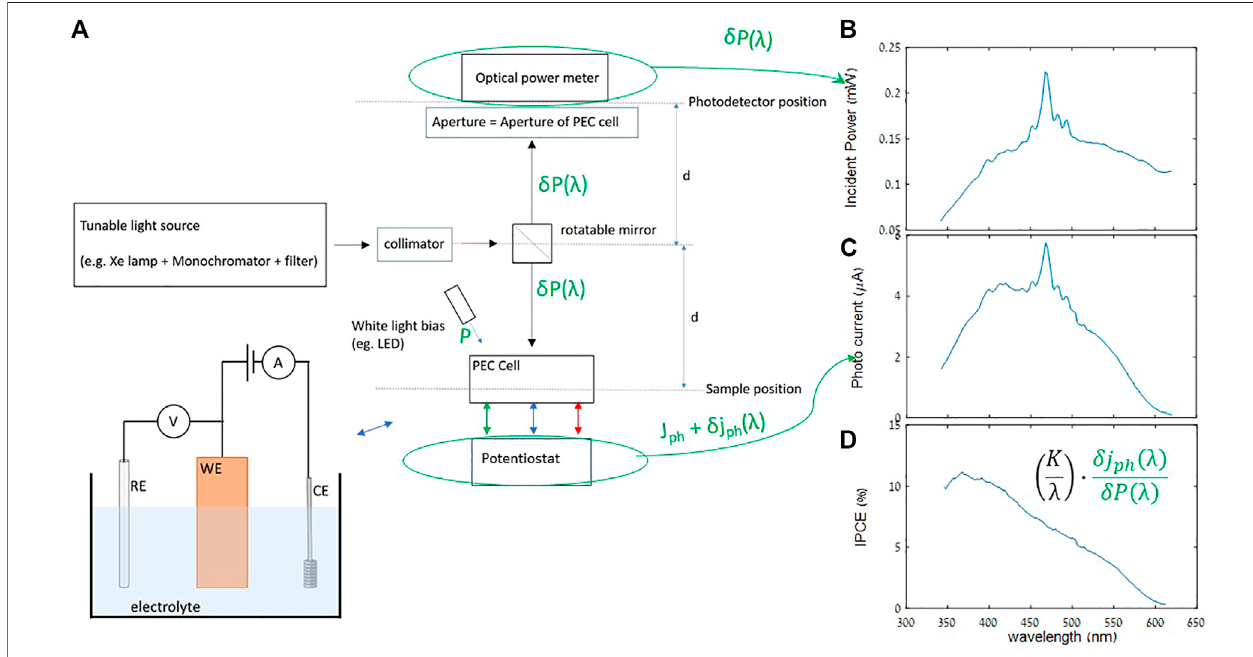
FIGURE 1 | (A) Basic IPCE setup. The three-electrode mode voltammetry measurement setup of the current – potential (J ph -U) curve of the PEC cell (using a potentiostat) is illustrated schematically in the bottom left, with the sample serving as the working electrode (WE), a reference electrode (RE) and counter electrode (CE), all in contact with the electrolyte. Typical measurements of optical power (B) and photocurrent (C) spectra, resulting in IPCE spectrum (D) , computed from the above with Eq. 1 Note that the bias light(of power P) from the LED leads toa bias photocurrentlevel ( J ph ) produced by the PEC cell, but the IPCE isdetermined from only the small signal